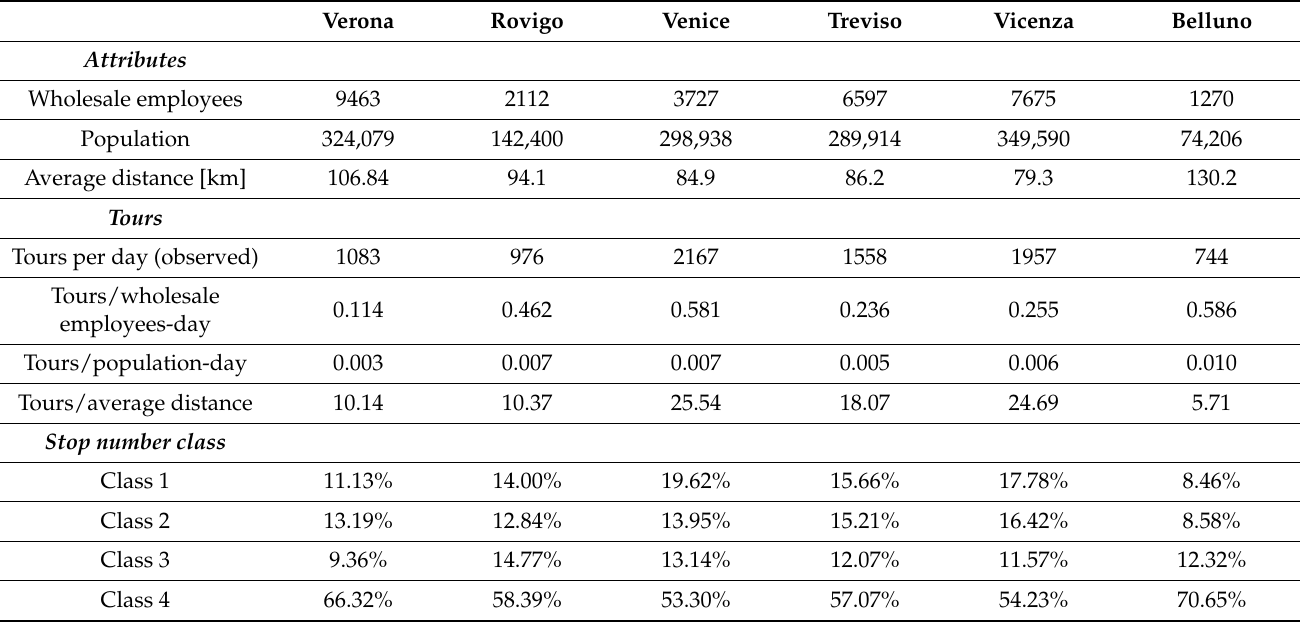
Table 3. Results of trip-chain order model for selected areas.